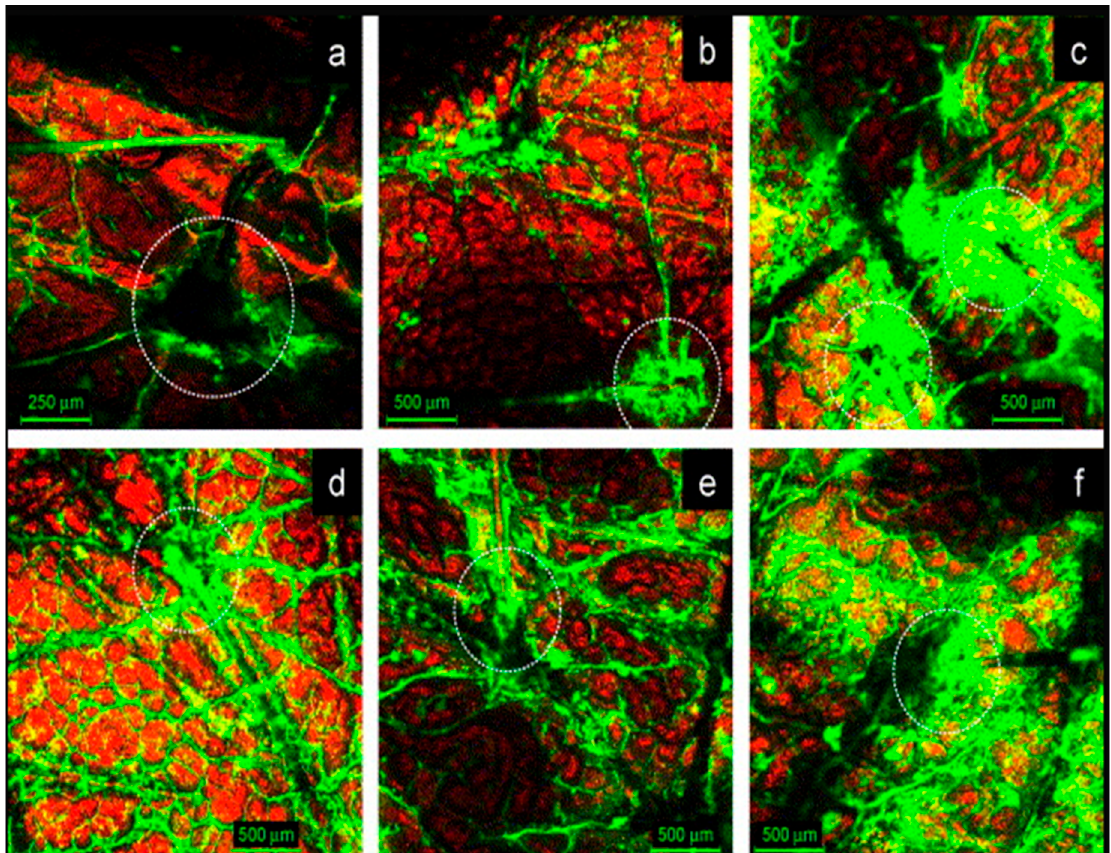
Figure 3. x-y images of the follicular localisation of fluorescent nanoparticles after application of nanoparticles (20 nm) for ( a ) 30 min, ( b ) 1 h and ( c ) 2 h and of nanoparticles (200 nm) for ( d ) 30 min, ( e ) 1 h and ( f ) 2 h. Hair follicles are represented by white circles. Reproduced from [184] with permission from Elsevier B.V Amsterdam. Key: Green fluorescence levels are localized to the follicular regions in figures ( a – c ), and the time-dependent accumulation of nanoparticles in hair follicles is shown in figures ( d – f ).